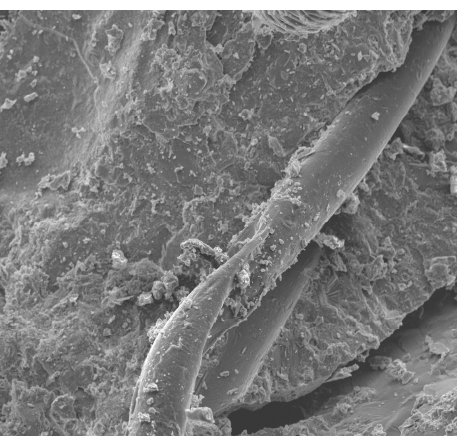
Figure 12. A fiber in the matrix and a scratch in the cement matrix at 100× magnification.